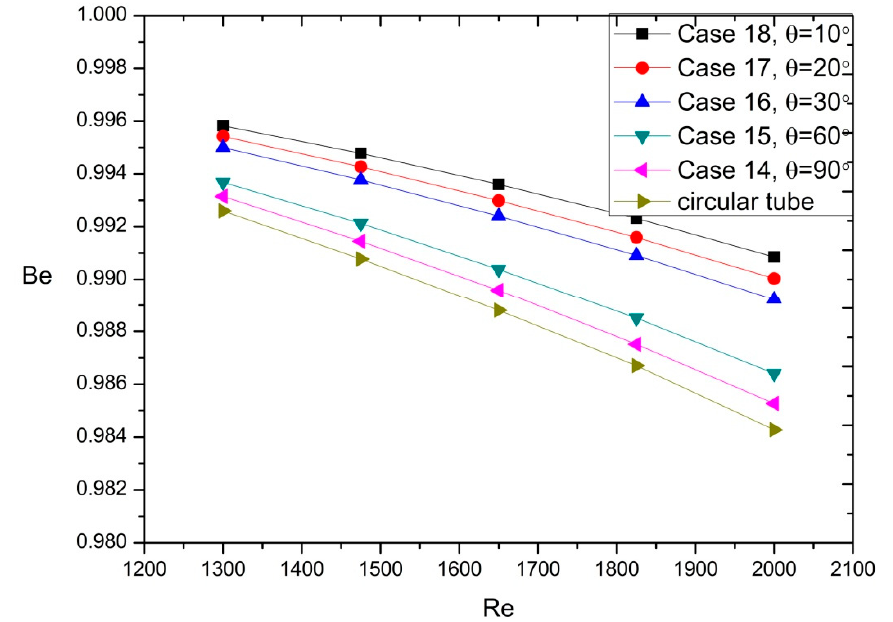
Figure 14. E ff ect of di ff erent angle on Be at di ff erent Reynolds Figure 14. Effect of different angle on Be at different Reynolds numbers.